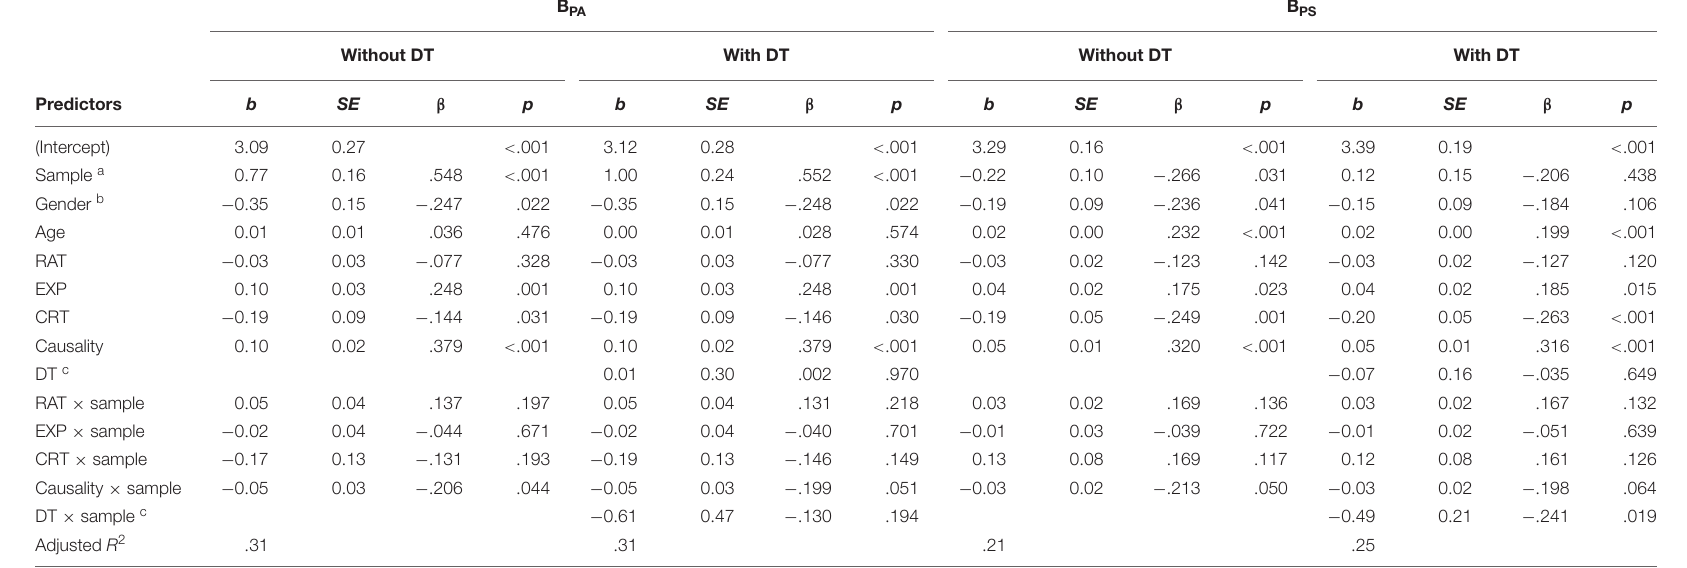
TABLE 5 | Regression analyses predicting beliefs by cognitive traits, cultural orientation, dialectical thinking, and interactions with sample (Study3). B PA B PS Without DT With DT Without DT With